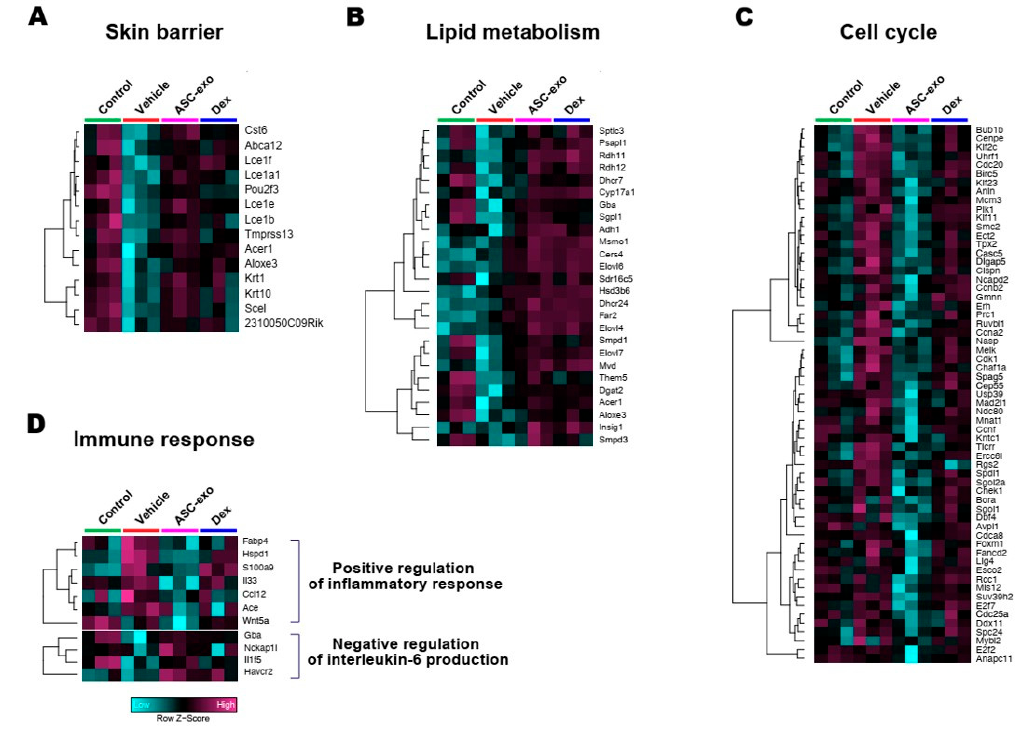
Figure 9. Heat map of DEGs between vehicle and ASC-exosomes that mapped to the indicated GO in Figure 8. ( A ) Skin barrier. ( B ) Lipid metabolism. ( C ) Cell cycle. ( D ) Immune